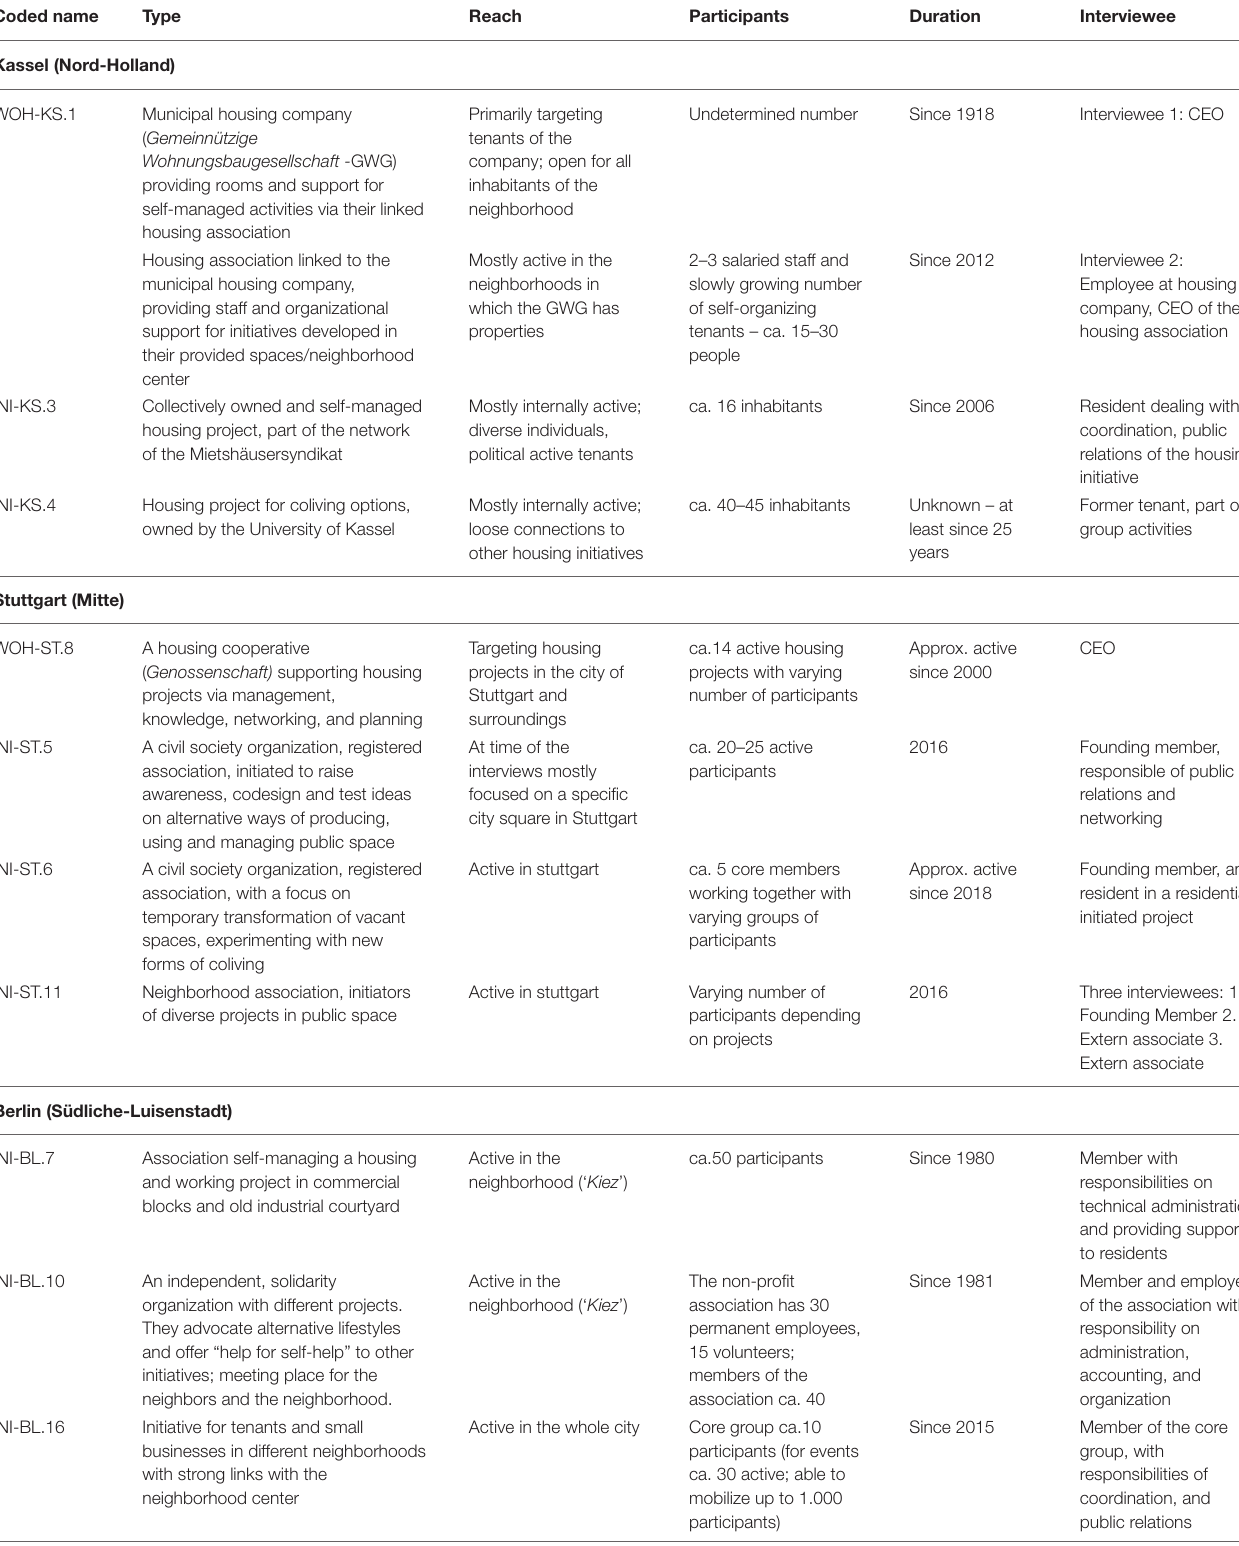
TABLE 1 | List of presented interviews with urban initiatives, housing companies and political